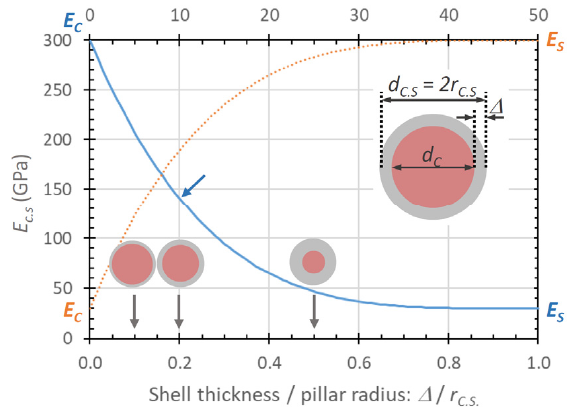
Figure 12. Core–shell pillar elastic modulus E C.S vs. shell thickness normalized to the core–shell pillar radius r C.S according to Equation (12) for the case of (i) sti ff core / compliant shell ( E C = 300 GPa / E S = 30 GPa) (blue line) as for pillar FEBID and FIBID, and (ii) compliant core / sti ff shell ( E C = 30 GPa / E S = 300 GPa) (orange dotted line) as may happen for e-beam curing. The total diameter 2 r C.S was kept constant. The inset shows the cross-section geometry related to Equation (12). Furthermore, three core–shell cross-sections were visualized for indicated shell thicknesses to pillar radii. For discussion, see text.